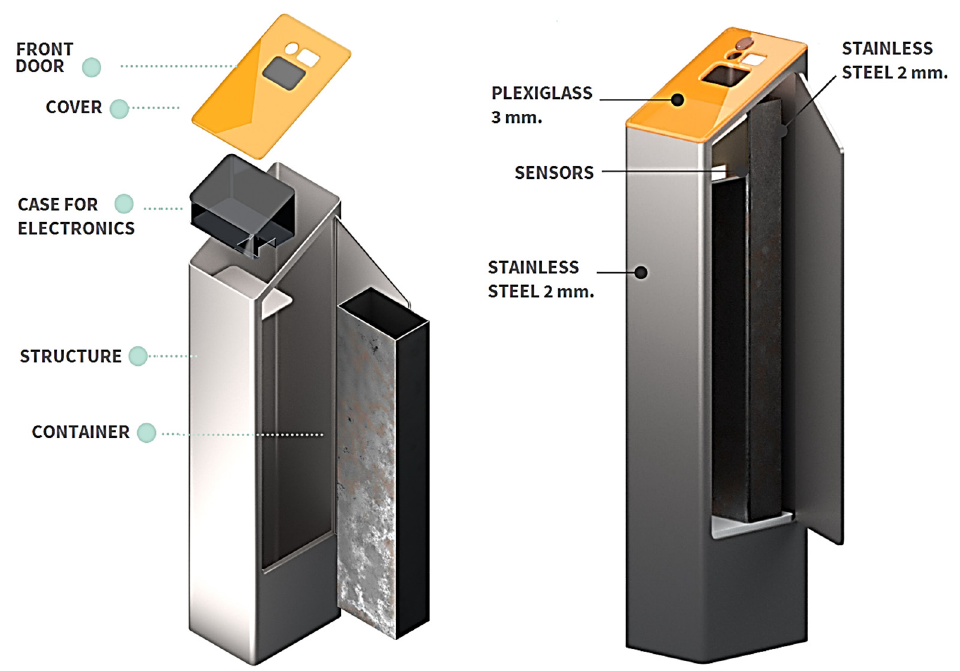
Figure 15. CAD 3D model.